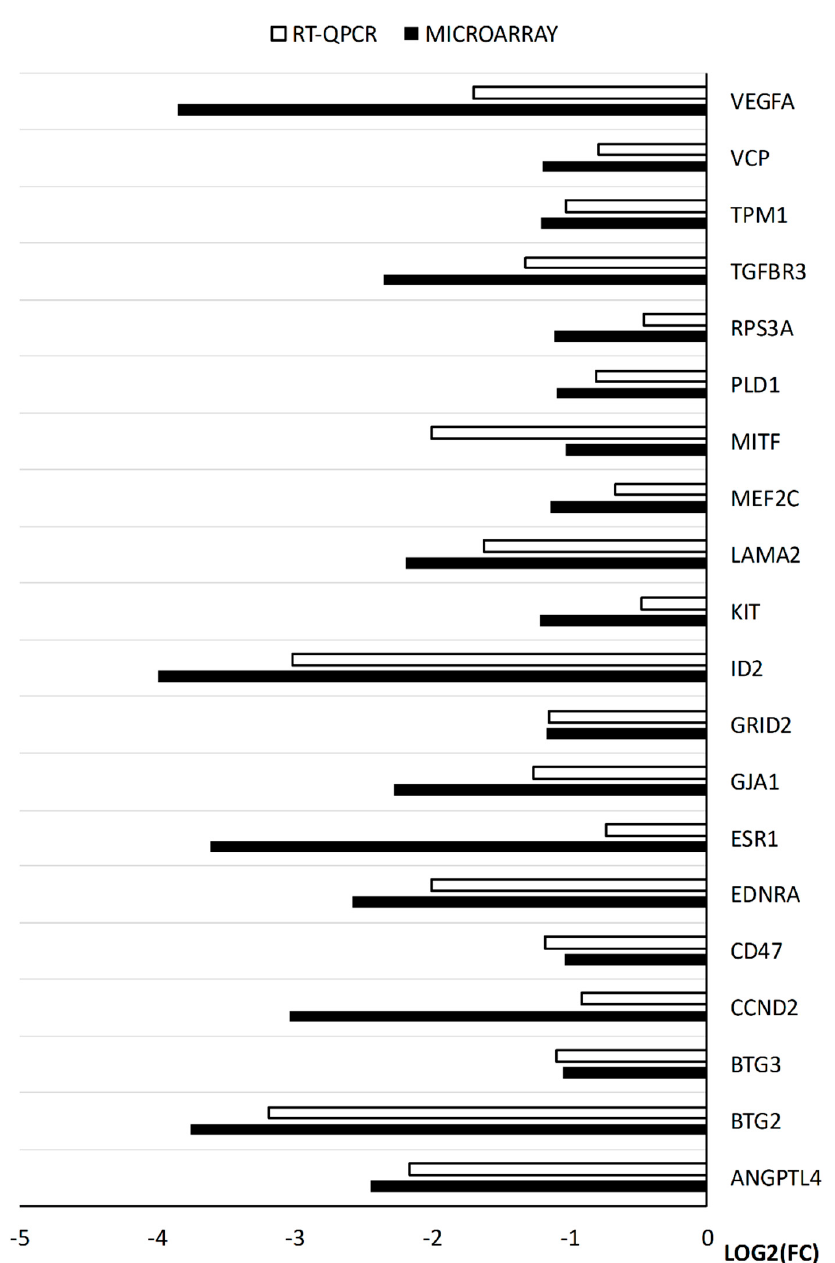
Figure 8. The results of the RT-qPCR validation of the analyzed genes, presented in a form of bar